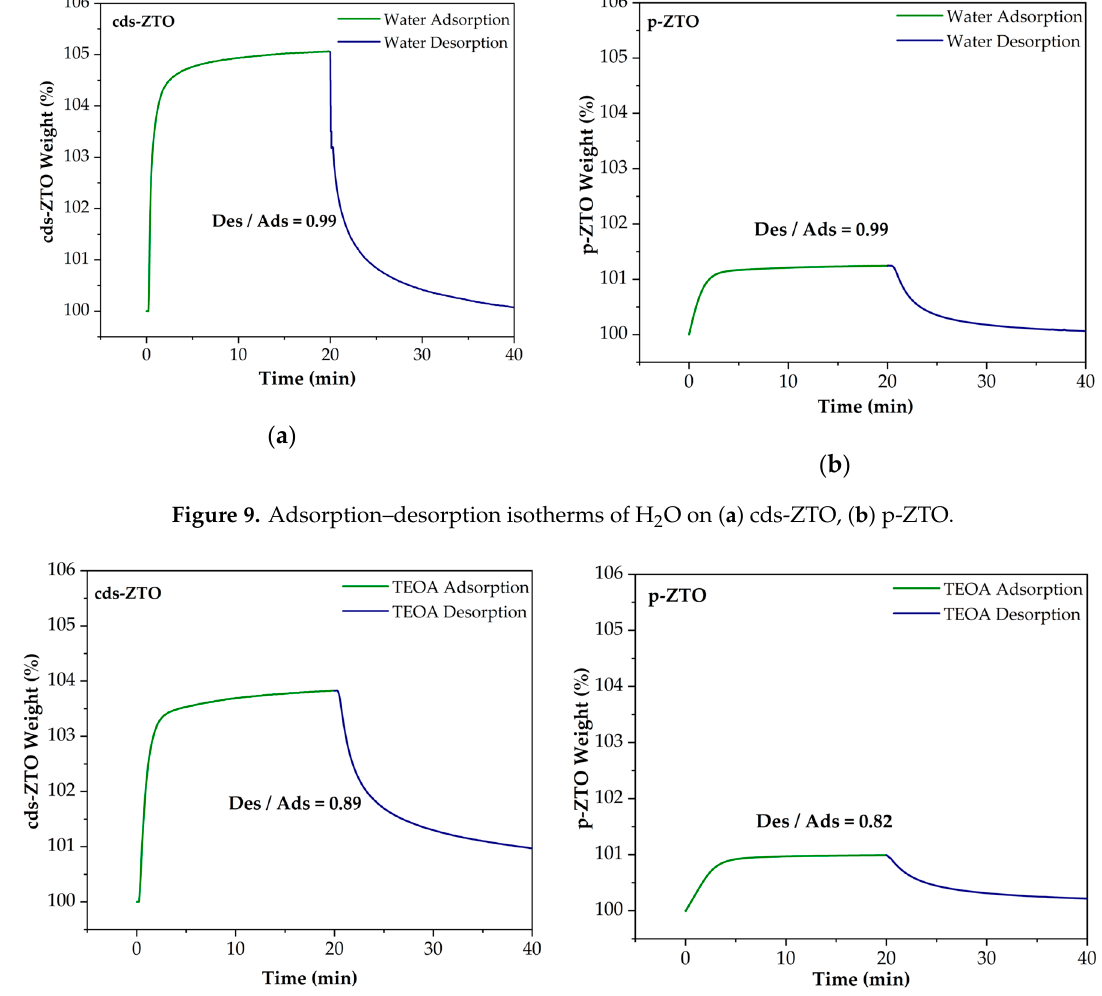
Figure 9. Adsorption–desorption isotherms of H 2 O on ( a ) cds-ZTO, ( b ) p-ZTO.